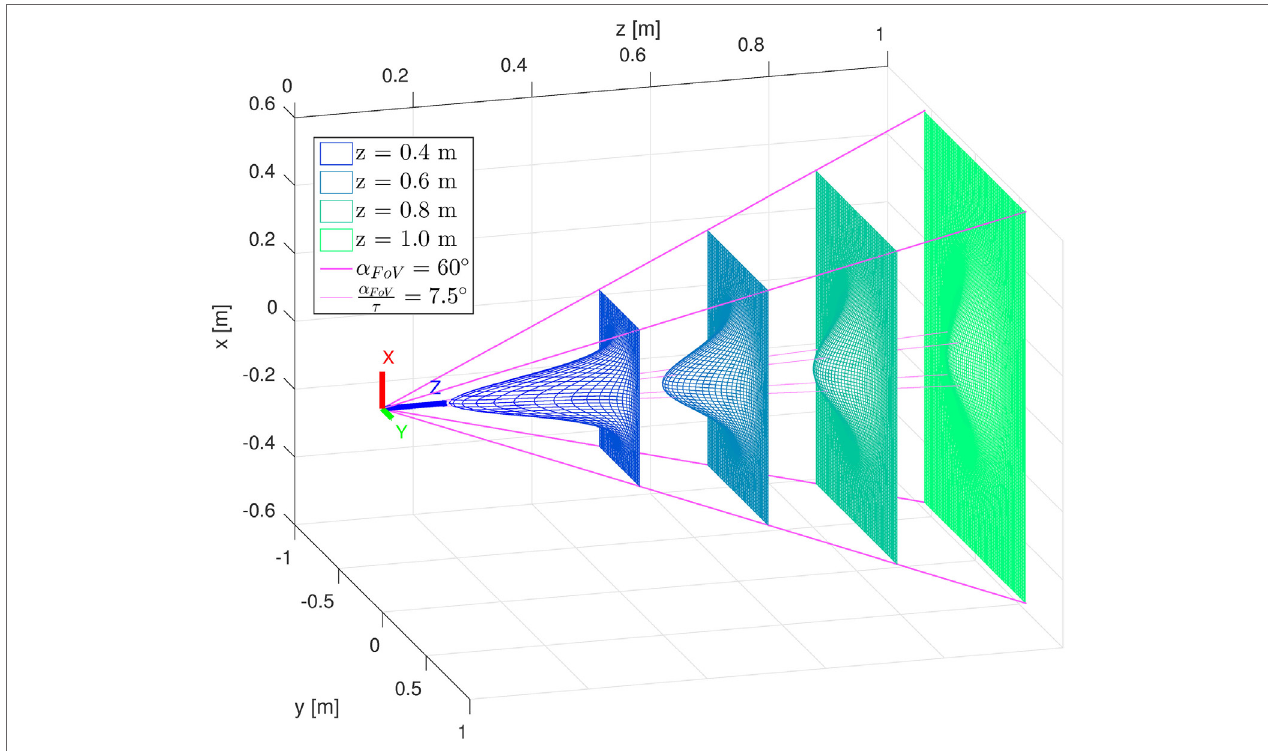
FigUre 3 | Attention measure v a ( p ) computed at different distances from the user’s face. Parameter τ is set to 8, decreasing the area where most of the attention is